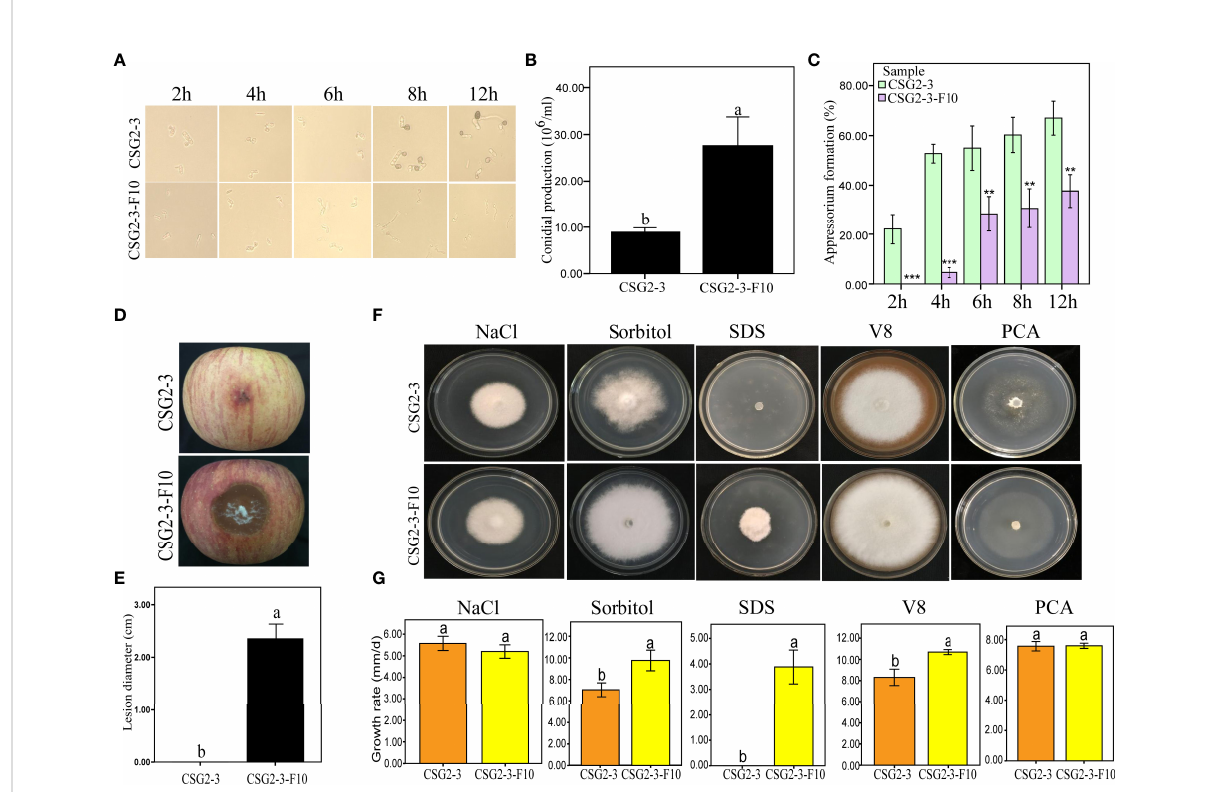
FIGURE 5 Growth and development of C . fructicola affected by virus infection. (A) Conidia were incubated on concave slides, and the samples were observed at different time points. (B) Conidial production of CSG2-3 and CSG2-3-F10. The different letters on the bars indicate signi fi cant differences at the a =0.05 level of con fi dence according to Student ’ s t -test. (C) The appressorium formation rates of CSG2-3 and CSG2-3-F10. The asterisks represent signi fi cant differences of CSG2-3 and CSG2-3-F10 at different periods (Student ’ s t -test, ‘ *** ’ , P<0.001 ‘ ** ’ , P<0.01). (D) The pathogenicity symptoms of CSG2-3 and CSG2-3-F10 conidial suspensions (6×10 5 conidial/mL). (E) The pathogenicity of CSG2-3 and CSG2-3-F10 conidial suspensions. The different letters on the bars indicate signi fi cant differences at the a =0.05 level of con fi dence according to Student ’ s t -test. (F) Phenotypic growth of CSG2-3 and CSG2-3-F10 on V8 media, PCA media, and potato dextrose agar (PDA) media containing 1 M NaCl, 1 M sorbitol, and 0.1% SDS components. Colonies were grown on PDA for 7 days and photographed. (G) Growth rates of CSG2-3 and CSG2-3-F10 on different media. Different letters indicate a signi fi cant difference at the a =0.05 level of con fi dence according to Student ’ s t